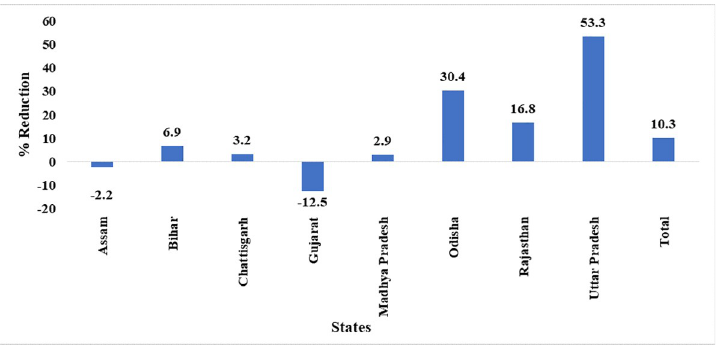
Fig 4. State wise reduction in mean expiry days left for vaccines a . a Data of Jharkhand, Manipur, Nagaland and Himachal Pradesh are not presented as the number of CCPs from these states are less than 30.